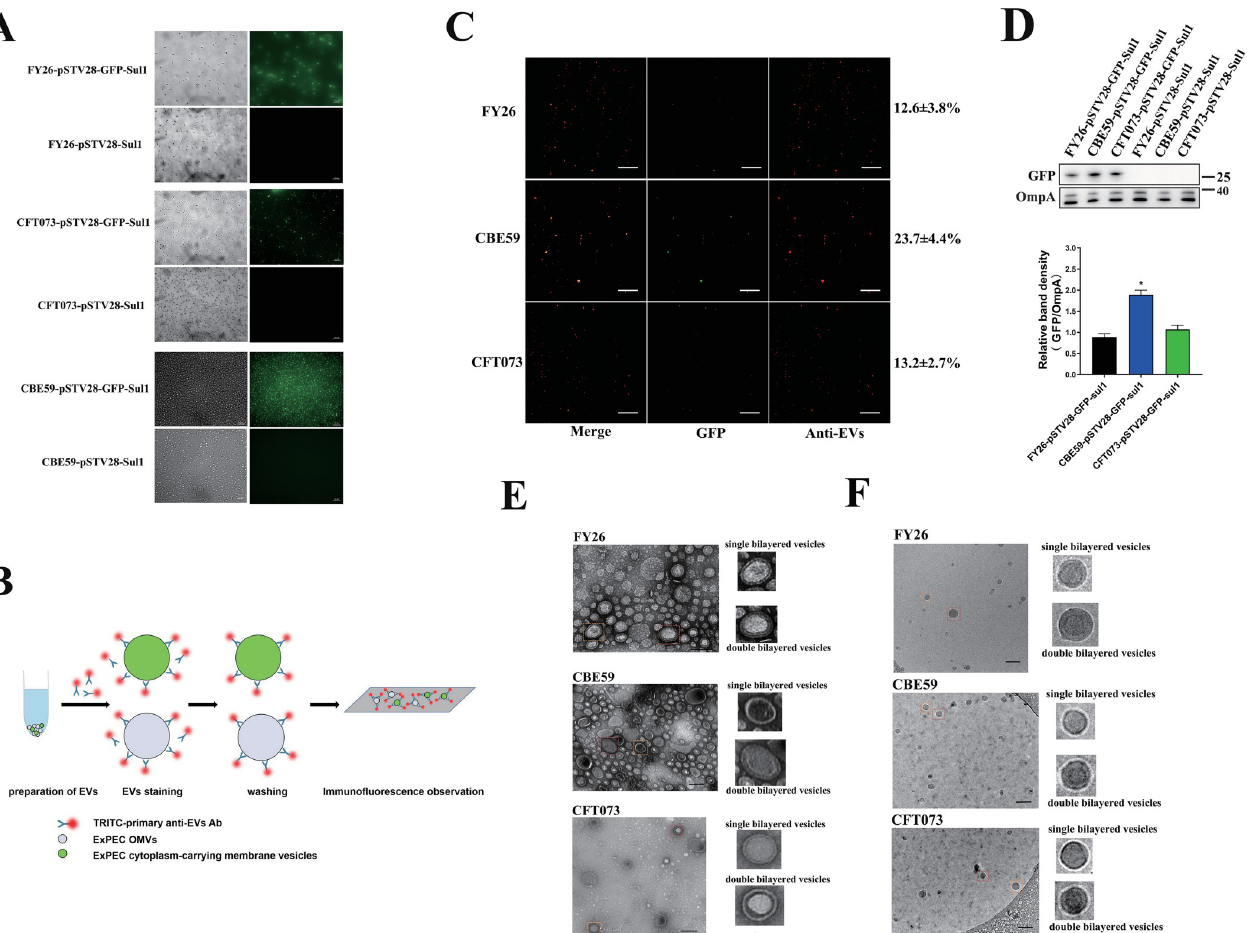
Fig 5. ExPEC EVs contain multiple types of vesicles. (A) Green fluorescent protein (GFP) in ExPEC strains was visualized with fluorescence microscopy. Scale bars: 20 μ m. (B) Illustration of experiment to detect cytoplasm-carrying membrane vesicles in ExPEC EVs. (C) Immunofluorescent images of EVs produced by ExPEC strains. The EVs were stained with TRITC-labeled primary mouse anti-EV antibody. The coexistence ratio of GFP-carrying vesicles (green fluorescence) among the total EVs (red fluorescence) represents the percentage of cytoplasm-carrying membrane vesicles, which is indicated on the right. Data were obtained from at least three independent experiments. Graphs show a representative image. Scale bars: 10 μ m. (D) GFP and OmpA proteins in EVs were determined with western blotting. (E) The outer–inner-membrane vesicles (OIMVs) of ExPEC were observed with transmission electron microscopy (TEM). ExPEC EVs displayed a double bilayered structure (red square), or single bilayered structure (orange square). Scale bars: 200 nm. (F) The outer–inner- membrane vesicles (OIMVs) of ExPEC were observed with Cryo-TEM. ExPEC EVs displayed a double bilayered structure (red square), or single bilayered structure (orange square). Scale bars: 200